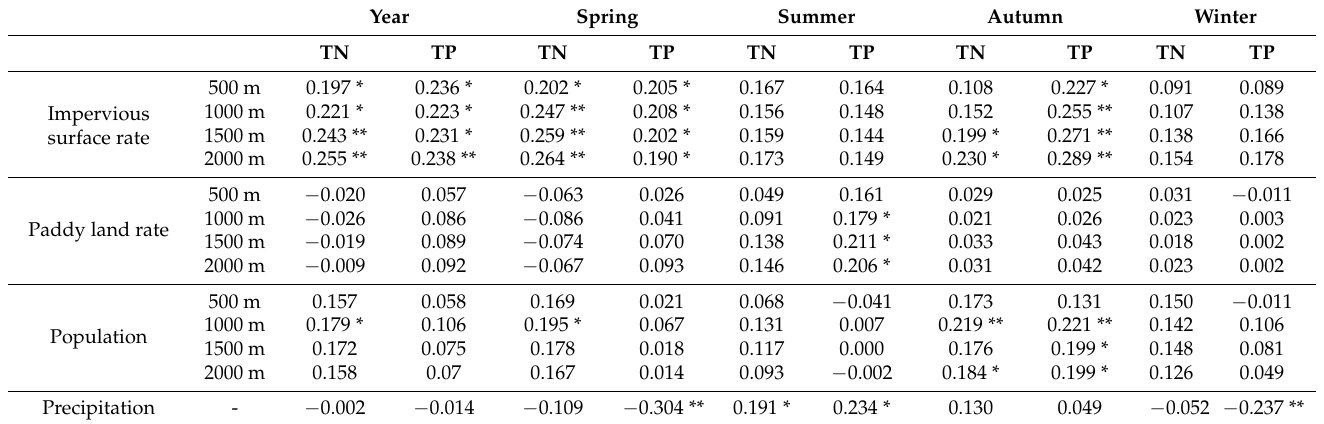
Table 6. Correlations between different factors and TN and